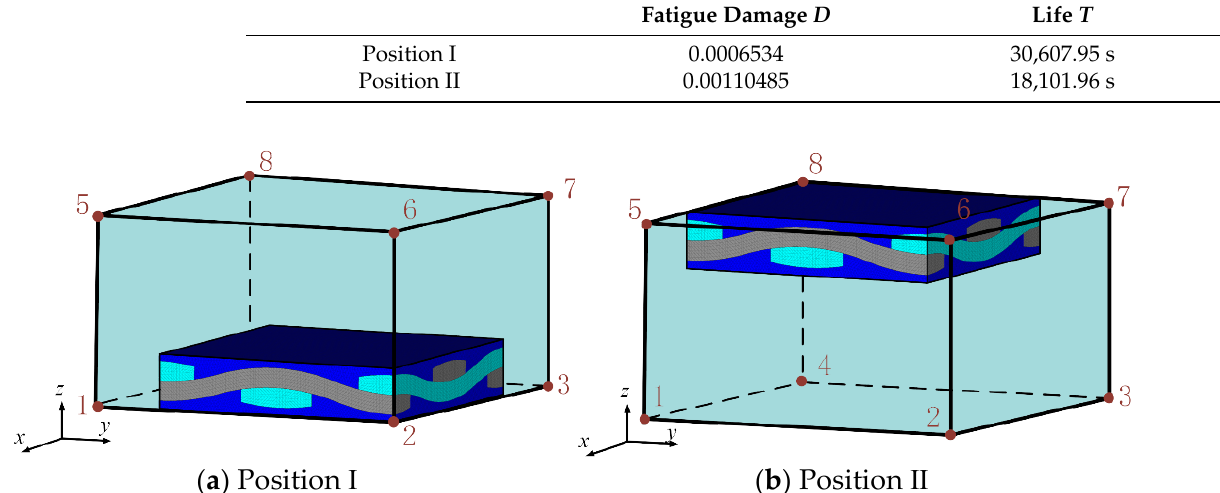
( b ) Position Ⅱ Figure 14. The maximum stress in the X direction of the yarn at different meso-model positions. Table 6. Fatigue analysis results of 2D SiC/SiC stiffened plates with different meso-model positions. Fatigue Damage D